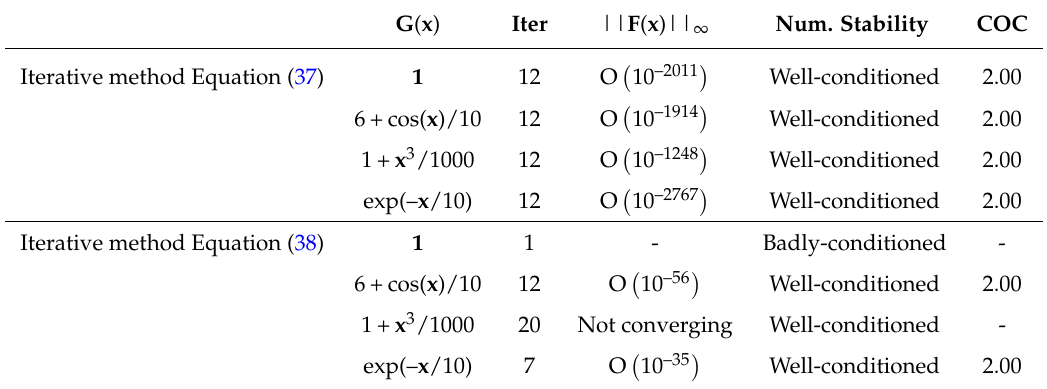
Table 3. Problem 3: initial guess = [2,4,3], m =